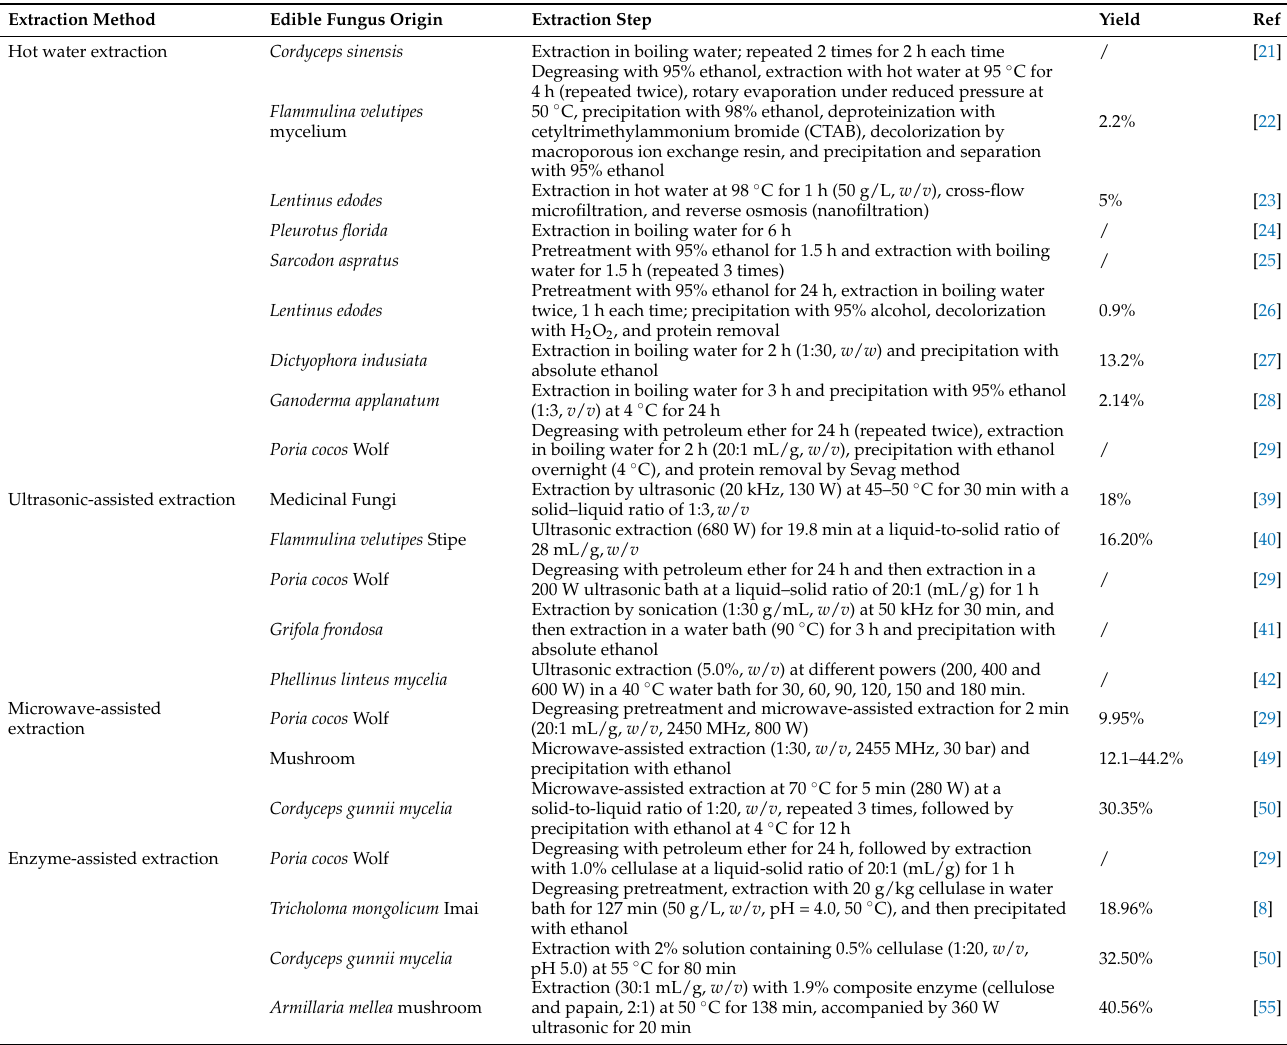
Table 1. Extraction method of edible fungus